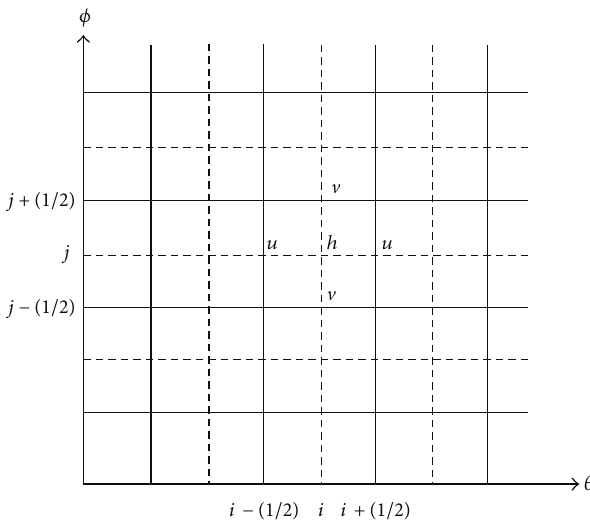
Figure 1: Staggered grid on space